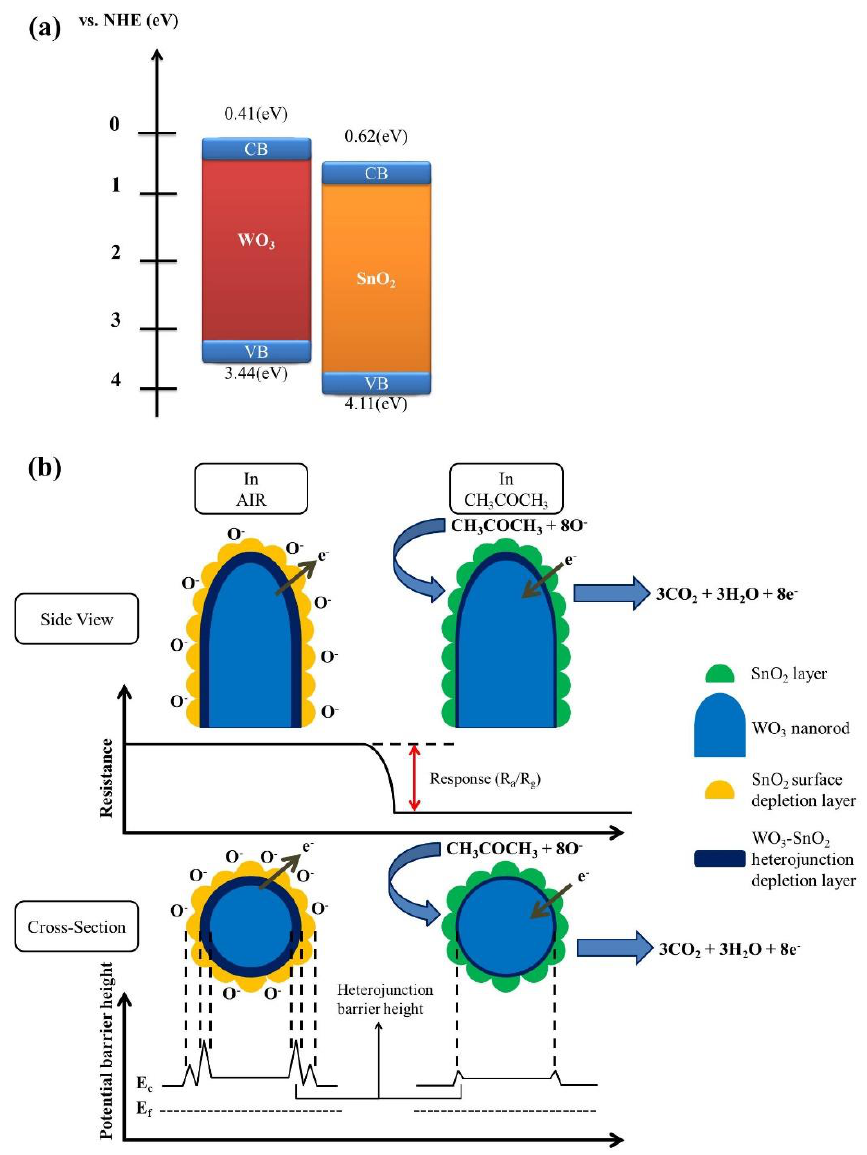
Figure 9. ( a ) The conduction band-edge and valence band-edge positions of the WO 3 and SnO 2 . ( b ) Schematics of possible gas-sensing mechanism of WS-1 nanorods on exposure to acetone vapor.